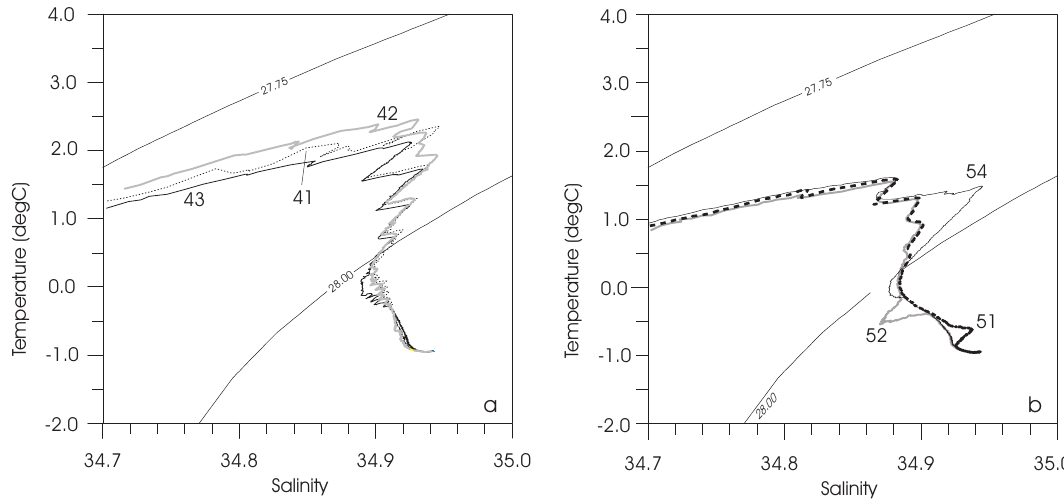
Fig. 13. Potential temperature vs. salinity (a) of stations 41, 42 and 43 in the Nansen Basin showing the anomaly of the water at station 42 and (b) of stations 51, 52 and 54 representing features of anomalous water in the Amundsen